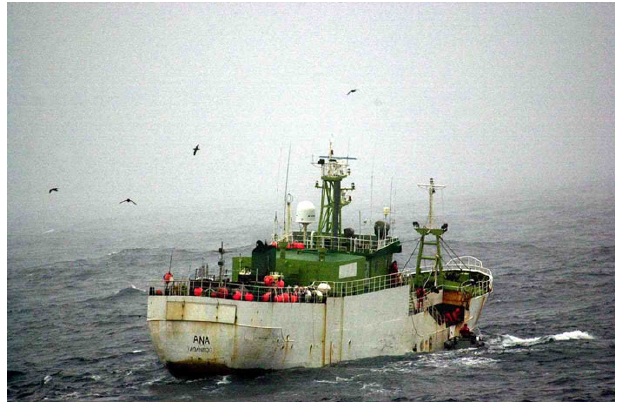
Fig. 1 . A suspected illegal, unreported, and unregulated (IUU) vessel using long lines directed to catch Patagonian toothfish ( Dissostichus eleginoides ) but also resulting in seabird mortalities. The vessel was boarded by Australian government agencies. Copyright Australian Fisheries Management Authority, used with